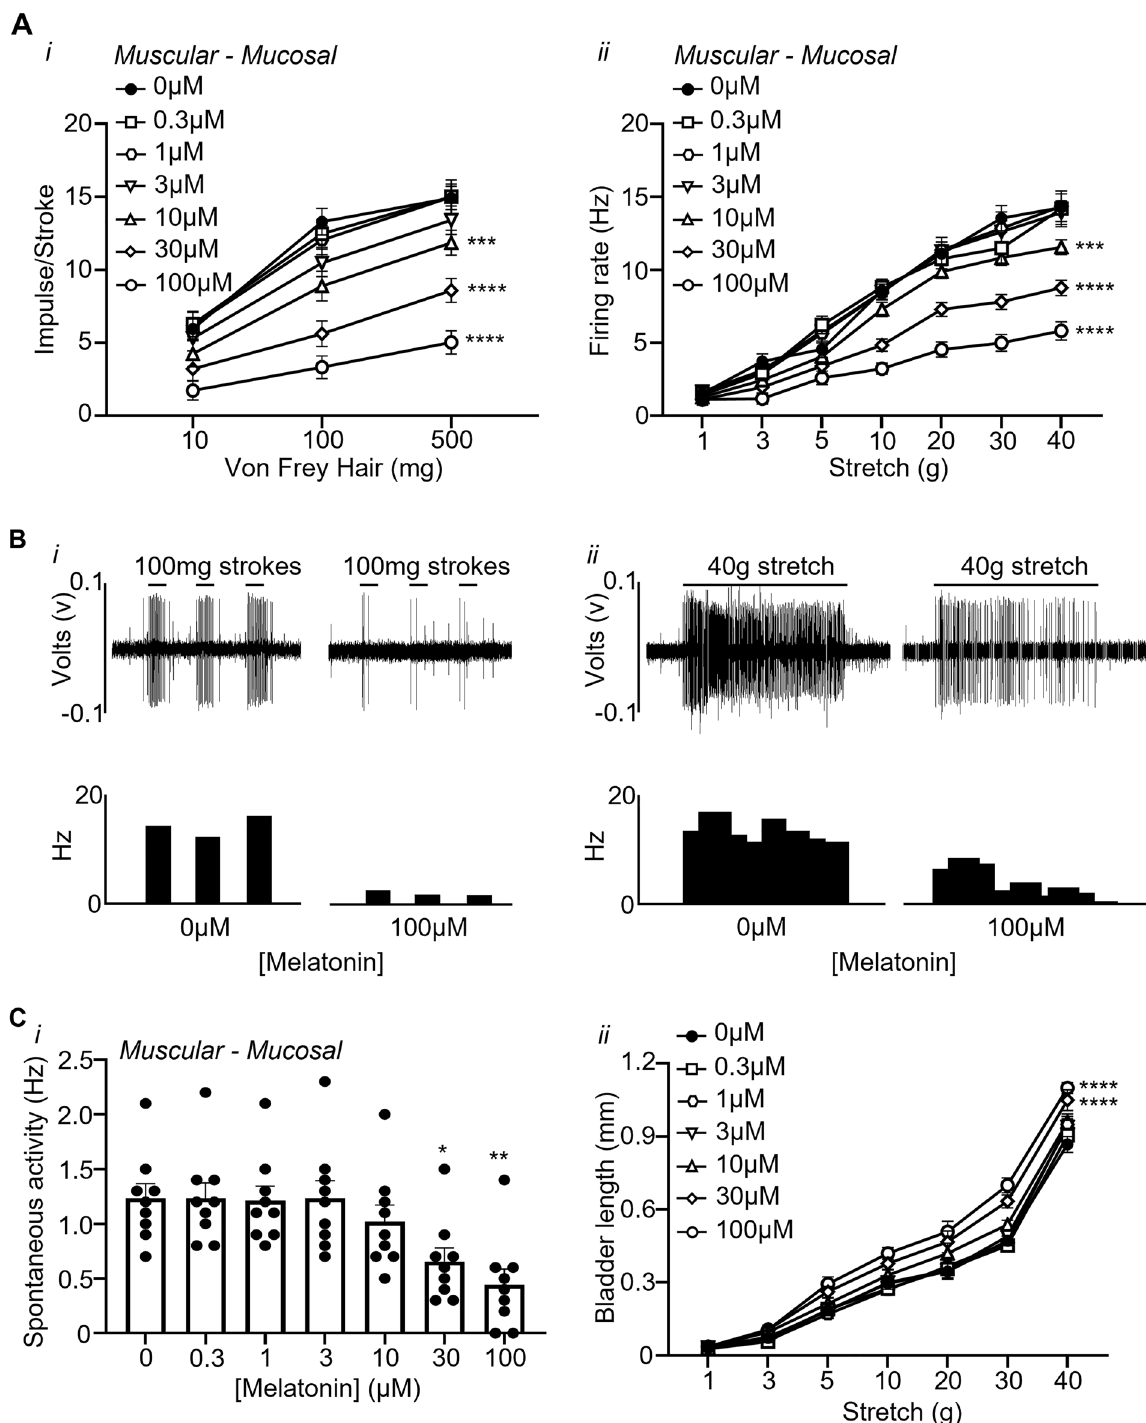
Figure 2. Melatonin inhibits the mechanosensitivity of muscular-mucosal bladder afferents. ( A ) The responses of low threshold muscular-mucosal afferents to ( i ) stroking (10, 100 and 500 mg) and ( ii ) stretch (1–40 g) in the absence or presence of melatonin (0.3–100 μM). ( B ) Raw trace examples of the response of melatonin to ( i ) stroking (100 mg) and ( ii ) stretch (40 g) in the absence and presence of melatonin (100 µM). ( C ) The effect of melatonin on the ( i ) spontaneous activity of muscular-mucosal bladder afferents and ( ii ) bladder length in the absence and presence of melatonin (0.3–100 µM). Data is presented as the mean ± the SEM, N = 8, n = 9. *P < 0.05, **P < 0.01, ***P < 0.001, ****P < 0.0001 vs 0 µM